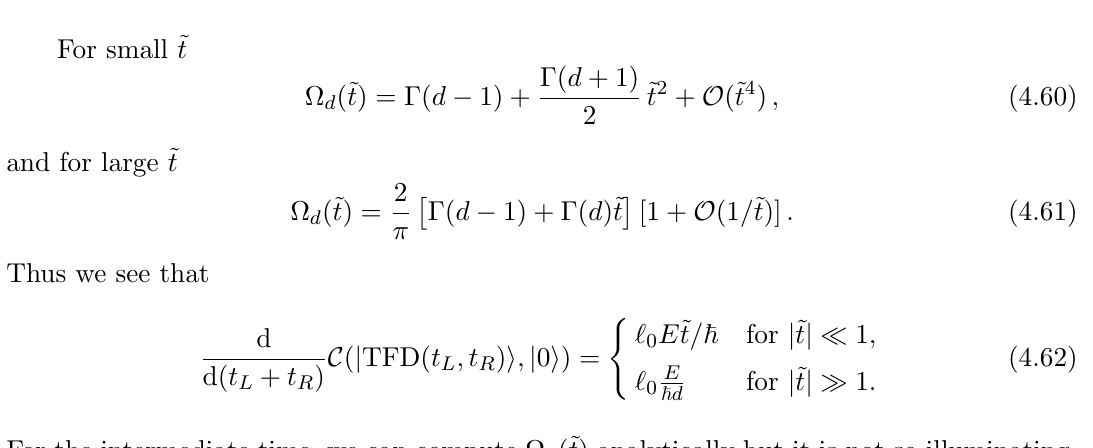
Figure 8 . The numerical values of complexity and its growth rate at d = 2 ; 3 ; 4 ; 5. C 0 is the complexity at ~ t = 0 and _ C f is the growth rate at the late time limit. From the left panel, we see that C will monotonously increase with respective to time ~ t . For small ~ t , _ C will linearly depends on ~ t . For large ~ t , _ C will tend to increase linearly with respective to ~ t and _ C tends to a constant. For large d , we obtain similar